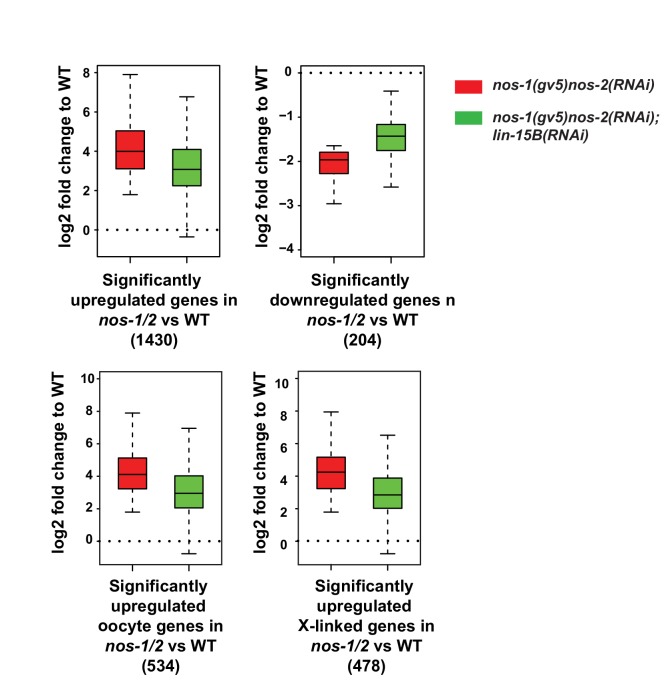
Loss of lin-15B activity mitigates gene expression changes in nos-1nos-2 PGCs.Box and Whisker plot showing log2 fold change compared to wild-type of different gene sets as depicted under each plot. Each box extends from the 25th to the 75th percentile, with the median indicated by the horizontal line; whiskers extend from the 2.5th to the 97.5th percentiles. Misregulation of all gene sets is reduced in nos-1(gv5)nos-2(RNAi);lin-15B(RNAi) PGCs.